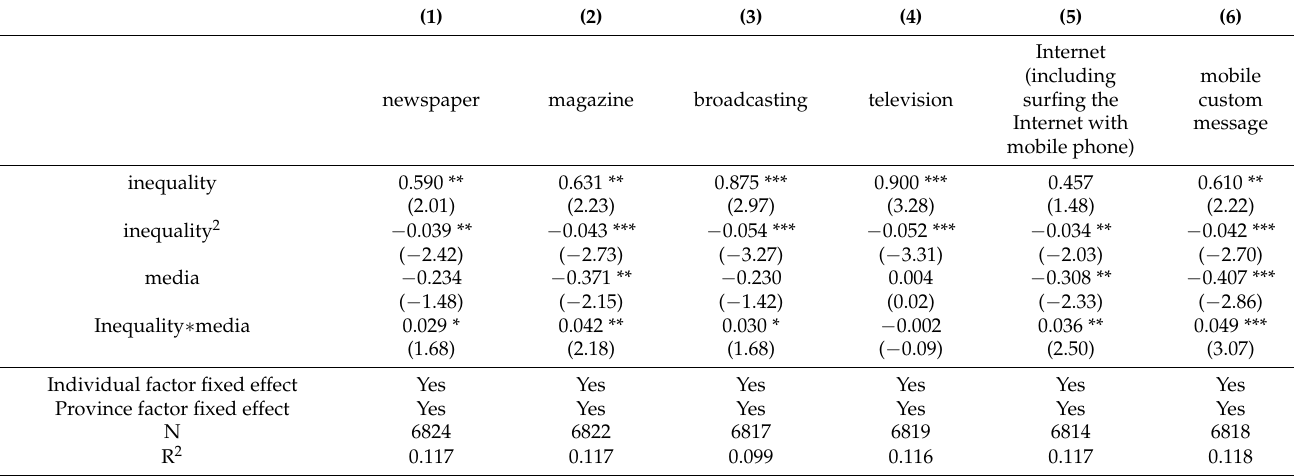
Table 15. The mechanism of the effect of individual-level income inequality on subjective environmental pollution: the effect of media